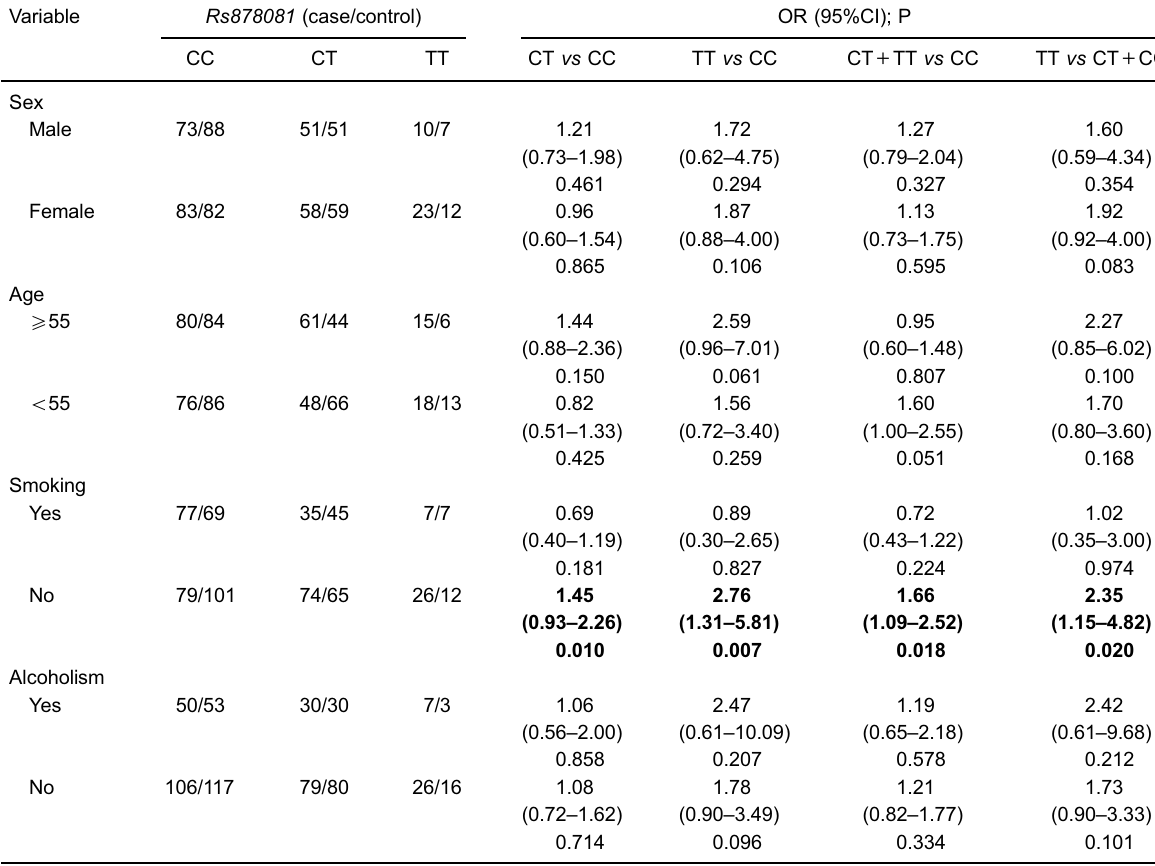
Table 3. Strati fi ed analyses between rs878081 polymorphism and the risk of rheumatoid arthritis strati fi ed by